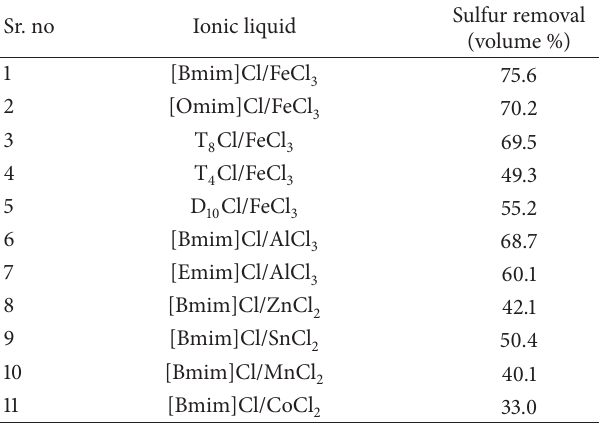
Table 1: Extractive desulfurization of model liquid fuel (DBT in n- dodecane) using Lewis-acid-based ionic